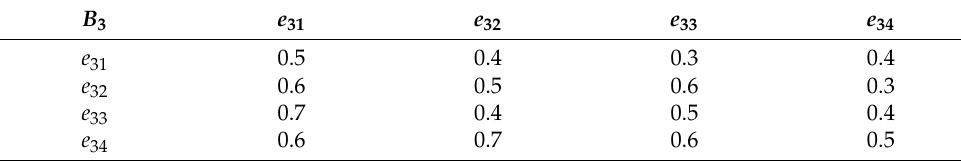
Table A20. Fuzzy symmetric matrix for influencing factors of slope geometry condition B 3 .